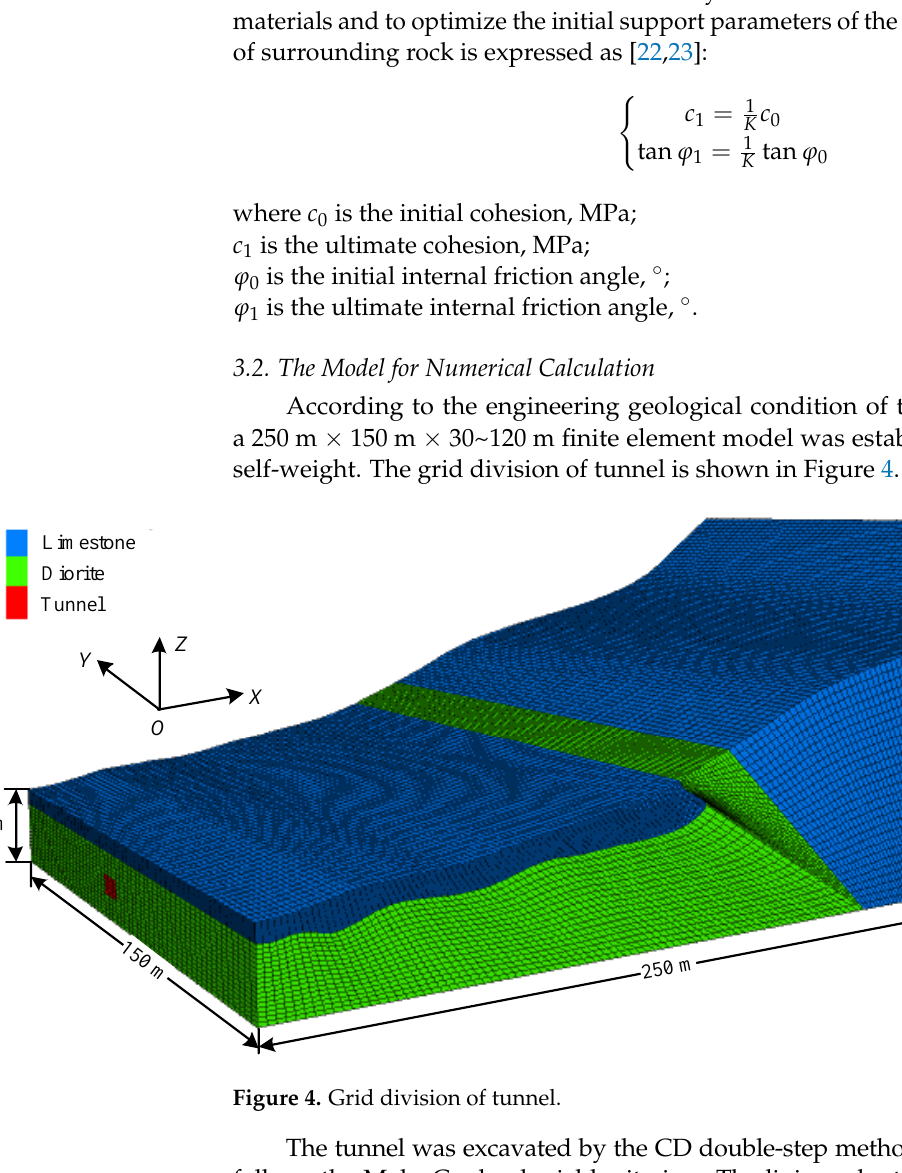
5 of 12 Figure 3. Monitoring curves for tunnel deformation. 3. Analysis of Tunnel Support Optimization Based on the Strength Reduction Method 3.1. Numerical Simulation Application of the Strength Reduction Method According to Specification for Design of Highway Tunnels (JTG 3370.1-2018), the initial uniaxial compressive strength of rock σ 0 is correlated with the ultimate uniaxial compressive strength σ 1 : 1 0 1 K  = (1) where σ 0 is the initial uniaxial compressive strength, MPa; σ 1 is the ultimate uniaxial compressive strength, MPa; K is the strength reduction coefficient. The strength reduction coefficient K is determined by the development degree of joints and fractures of macro rock mass. The strength reduction method is introduced into